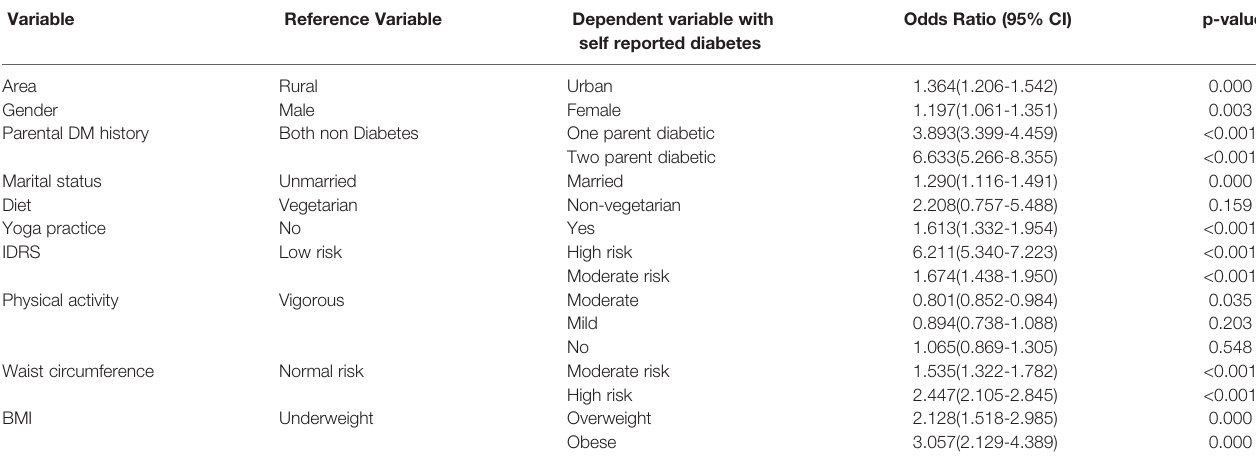
TABLE 5 | Multinomial logistic regression analysis showing the odds of diabetes within each